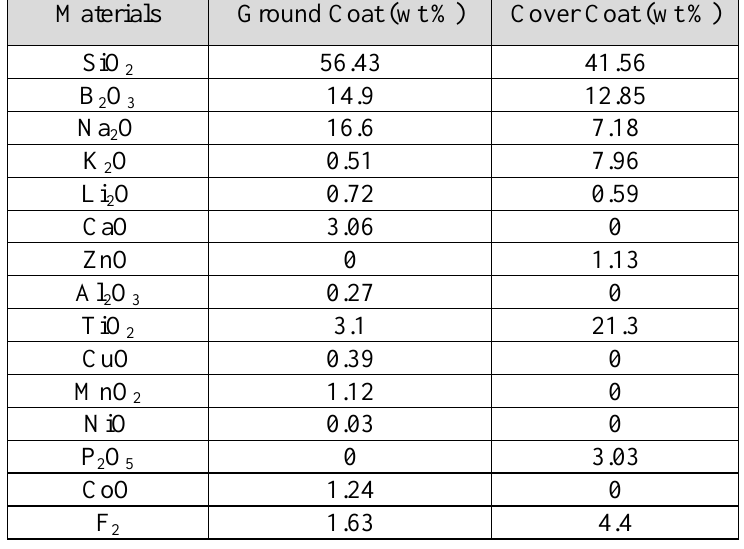
Table 1: Materials used in the preparation of the ground coat and cover coat